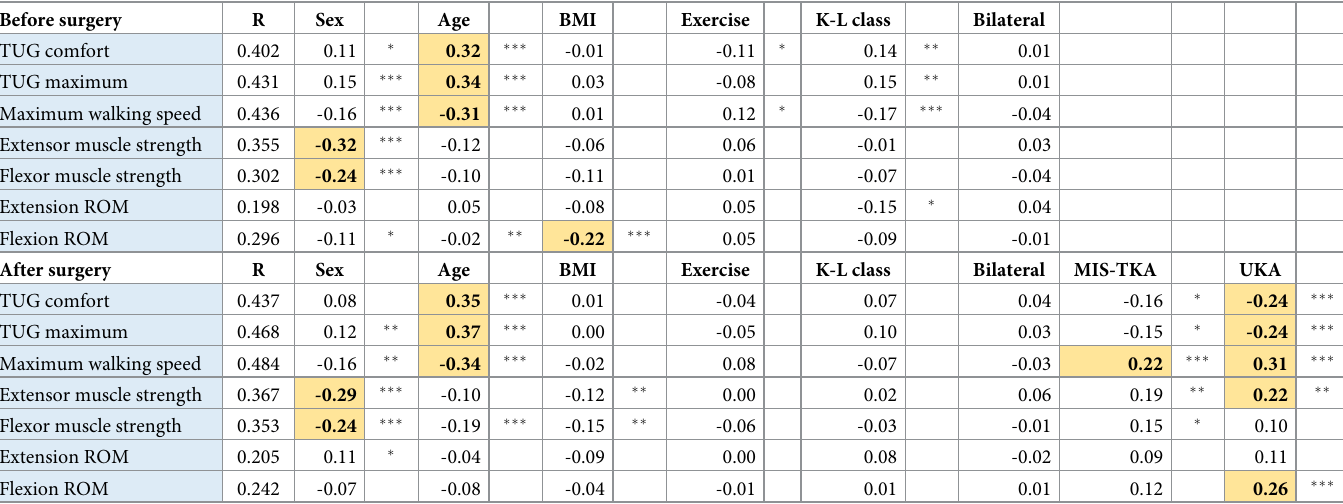
Table 2. Multiple regression analyses for sources of variation of motor function parameters. Before